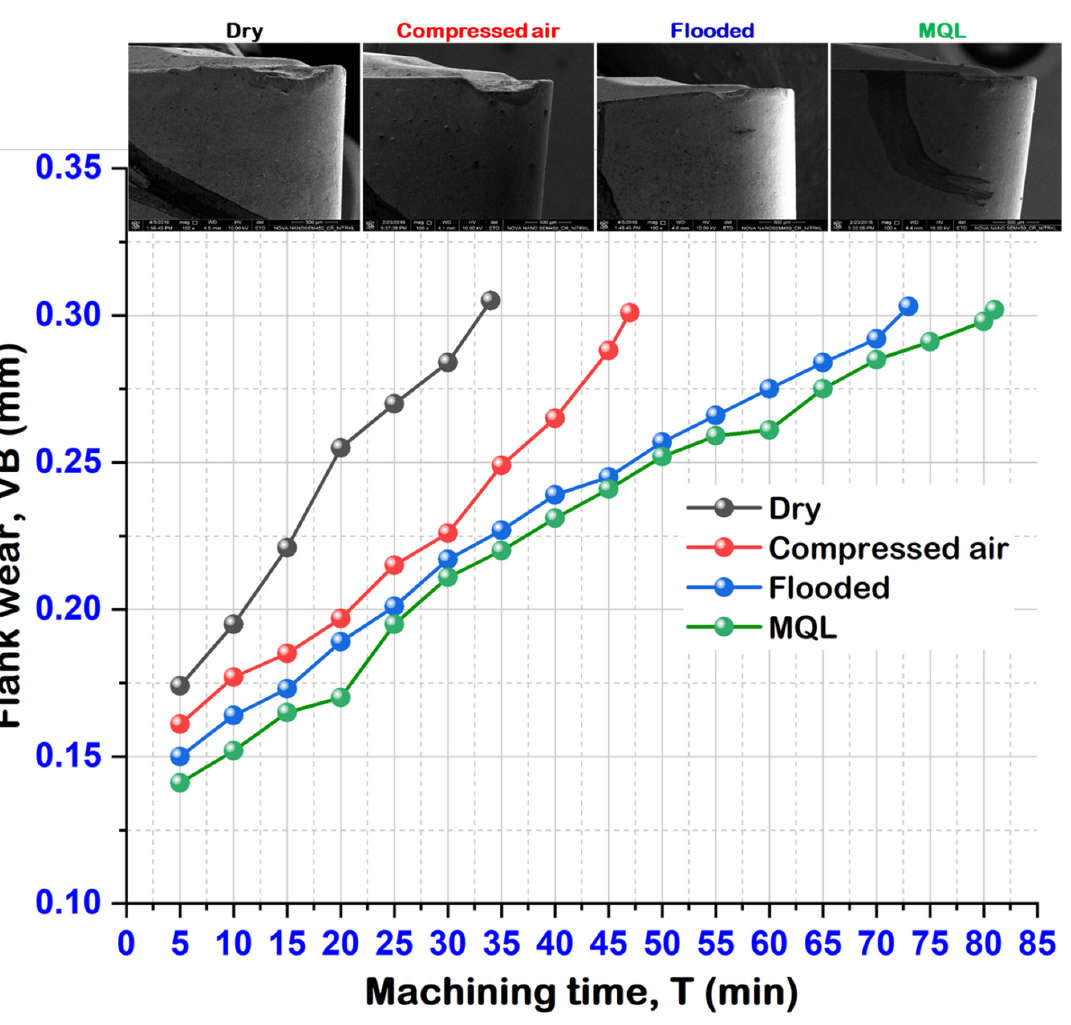
Figure 8. Tool life illustrating the progression of flank wear up to 0.3 mm under various cutting environments at f = 0.24 mm/rev, v = 111 m/min.